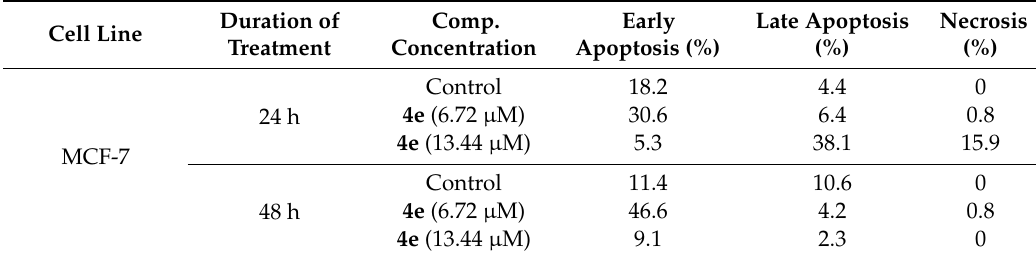
Table 4. Results of the Annexin V assay a